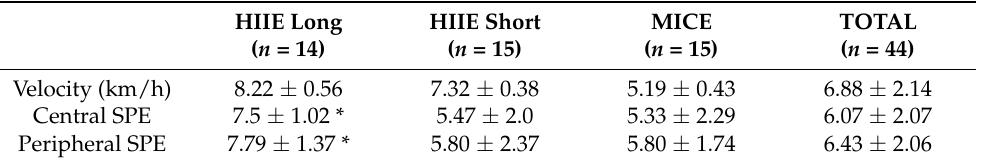
Table 2. Mean values of speed and subjective perception of exertion of patients with DM2 organized by